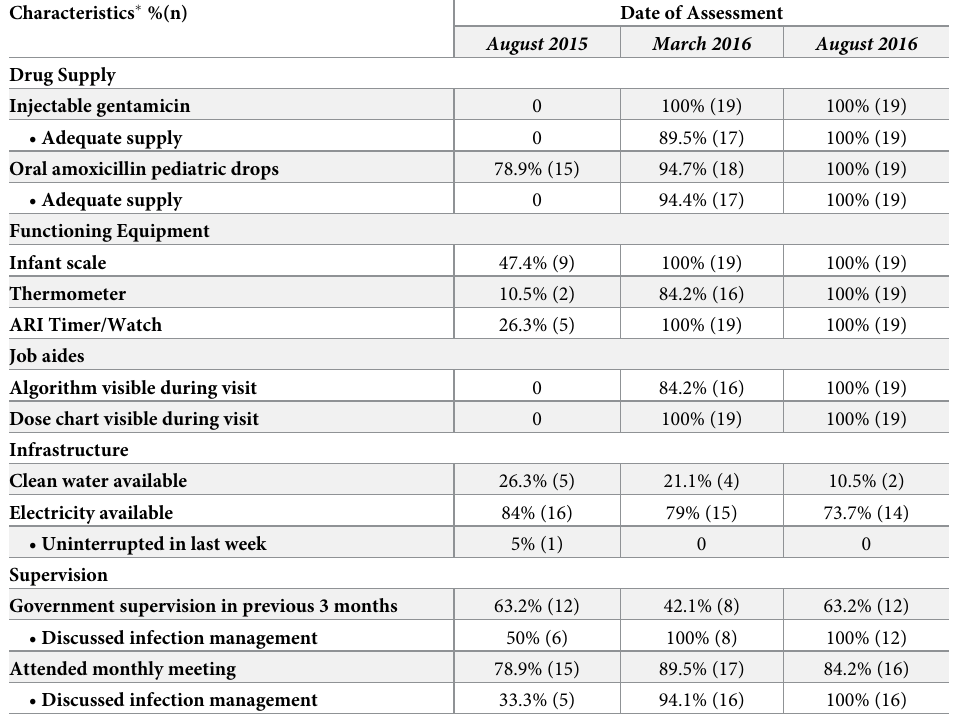
Table 3. Availability of core drugs and equipment at health centers for infection management and frequency of supervision visits throughout the study period (N = 19). Characteristics �